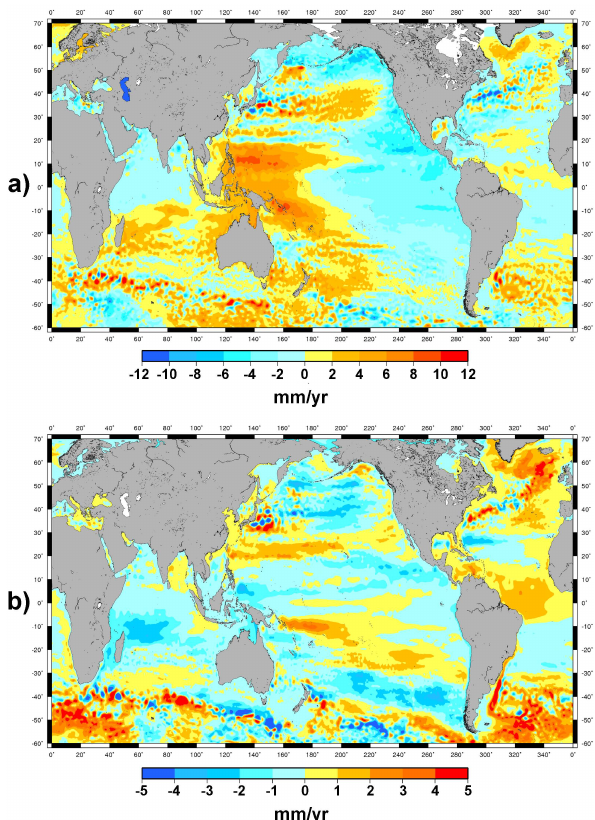
Fig. 1. Satellite altimetry sea level trends over 1993–2009 and re- constructed past sea level trends over 1950–2009. (a) Trends com- puted from the weekly AVISO sea level dataset. Time series have been averaged to annual time series. A global averaged sea level trend of 3.3mmyr − 1 has been removed. (b) Reconstructed sea level trends over 1950–2009 (the reconstruction total time span); a global averaged sea level trend of 1.76mmyr − 1 has been removed. The time series have been averaged to annual time